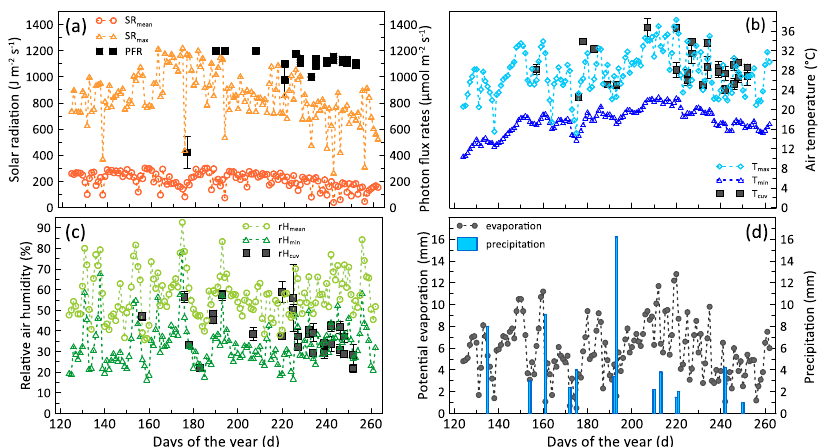
Figure 1. Climatic condition during the growing season. ( a ) Mean (circles) and maximum (triangles) daily energy flux rates of solar radiation ( SR , J m −2 s −1 ) and photosynthetic photon flux rate ( PFR , µmol m −2 s −1 ) on top of the gas exchange leaf cuvette (filled squares). ( b ) Daily minimum and maximum air temperature (°C) and temperature of leaves in the cuvette (°C). ( c ) Minimum and maximum values of relative air humidity (rH) measured in the gas exchange cuvette. ( d ) Daily values of pan evaporation (filled circles) and total precipitation (bars).